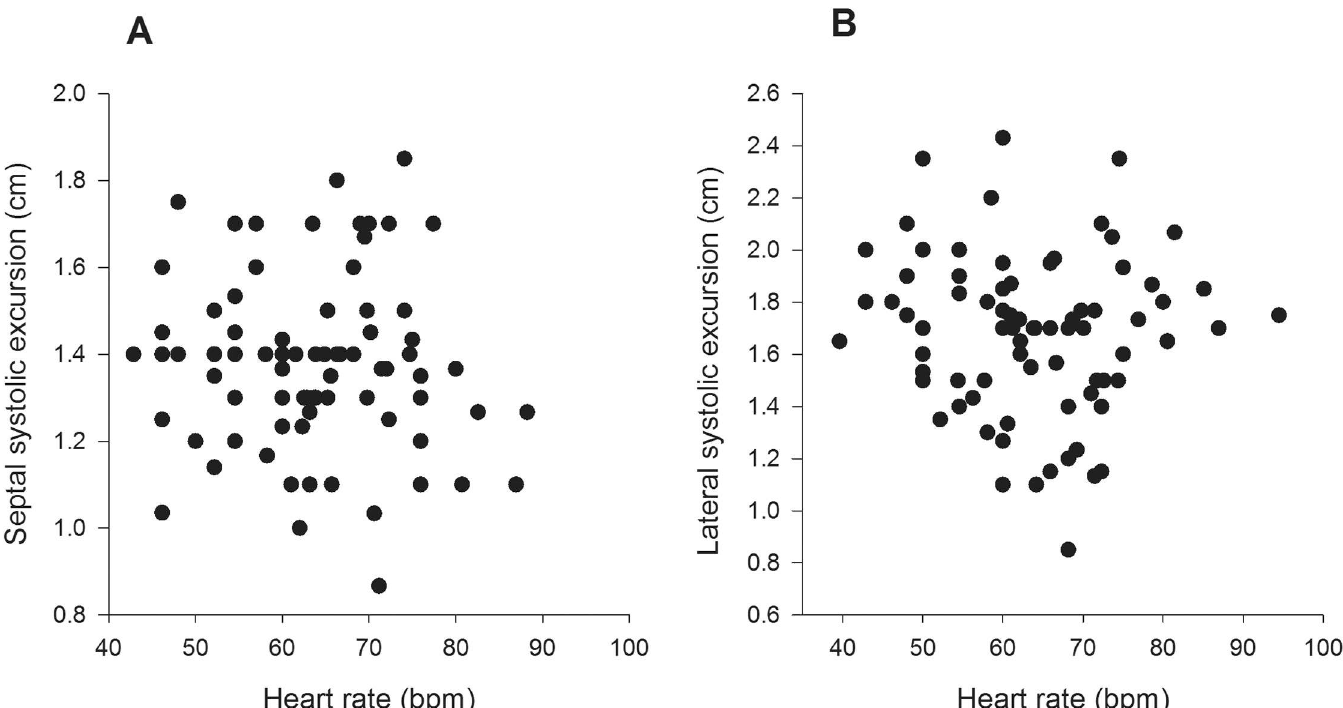
Fig 4. Scatter plots of heart rate v septal SExc (A) and heart rate v lateral SExc (B) in Group 1.